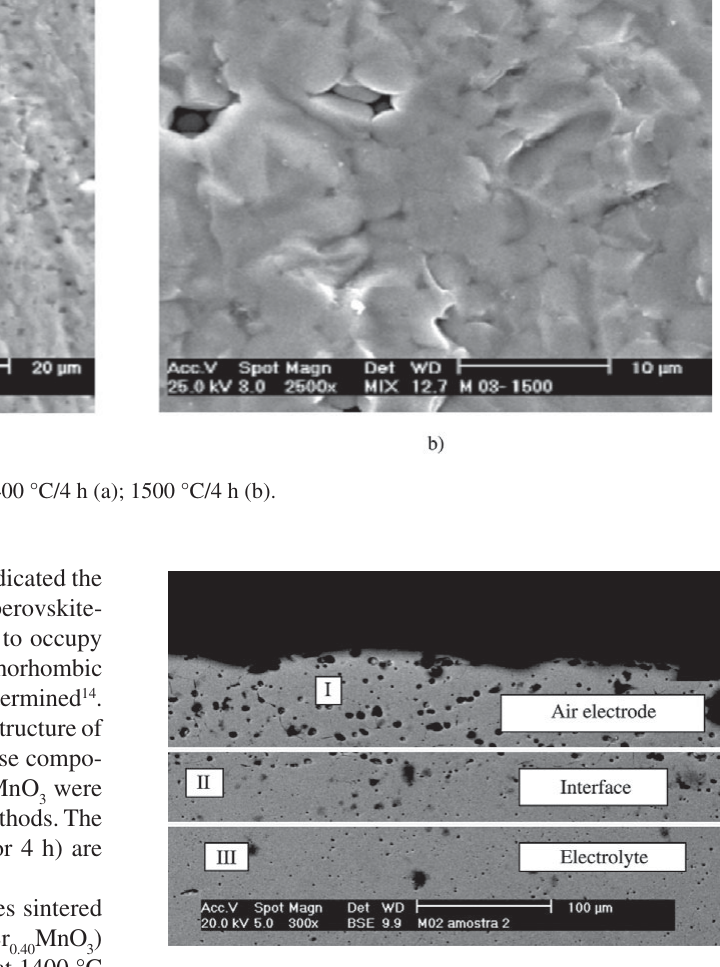
Figure 3. SEM micrograph of a porous cathode deposited via slurry coating on an electrolyte substrate.